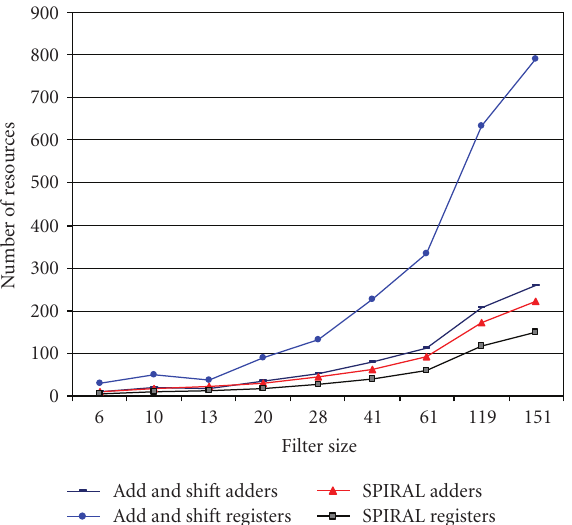
Figure 15: High level resource utilization in terms of # adders and registers for various filters using add and shift method (this paper) versus SPIRAL automatic software. SPIRAL shows a saving of 15% in number of adders and 81% in number of registers at the cost of 68% drop in